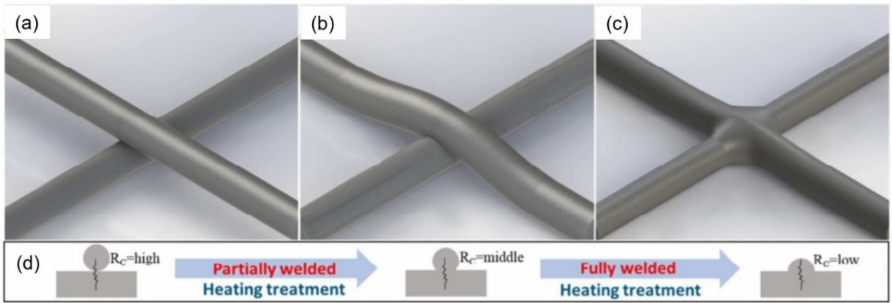
Figure 29. ( a – c ) Schematic illustration of welding process for nanofiber networks. ( d ) Contact resistance variation at the nanojoint. Adapted with permission from [349]. Copyright 2018 Royal Society of